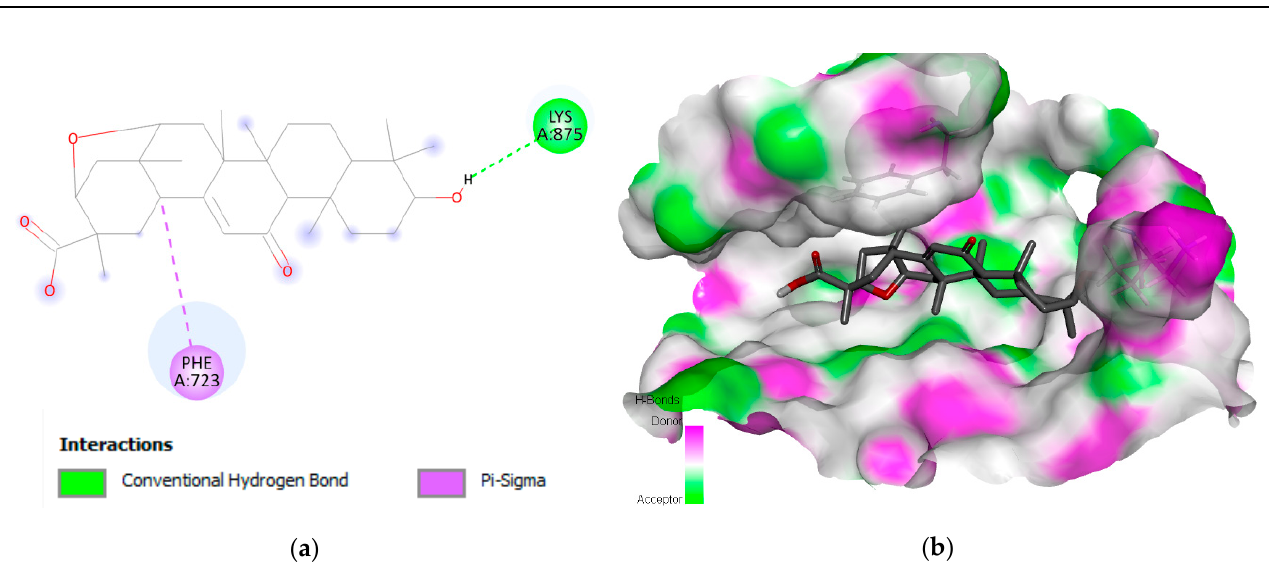
Liquoric acid revealed interactions with PheA:723 and LysA:8775 amino acids of EGFR protein with a binding or S-score of − 9.8 kcal/mol (Figure 1). A conventional H-bond with LysA:875 was found in the complex and a Pi–sigma (PheA:723) was also observed in the complex. The Pi–sigma interactions (i.e., Pi–alkyl and Pi–sulfur) help to intercalate the drug in the binding pocket of the receptor as they are largely involved in the charge transfer.